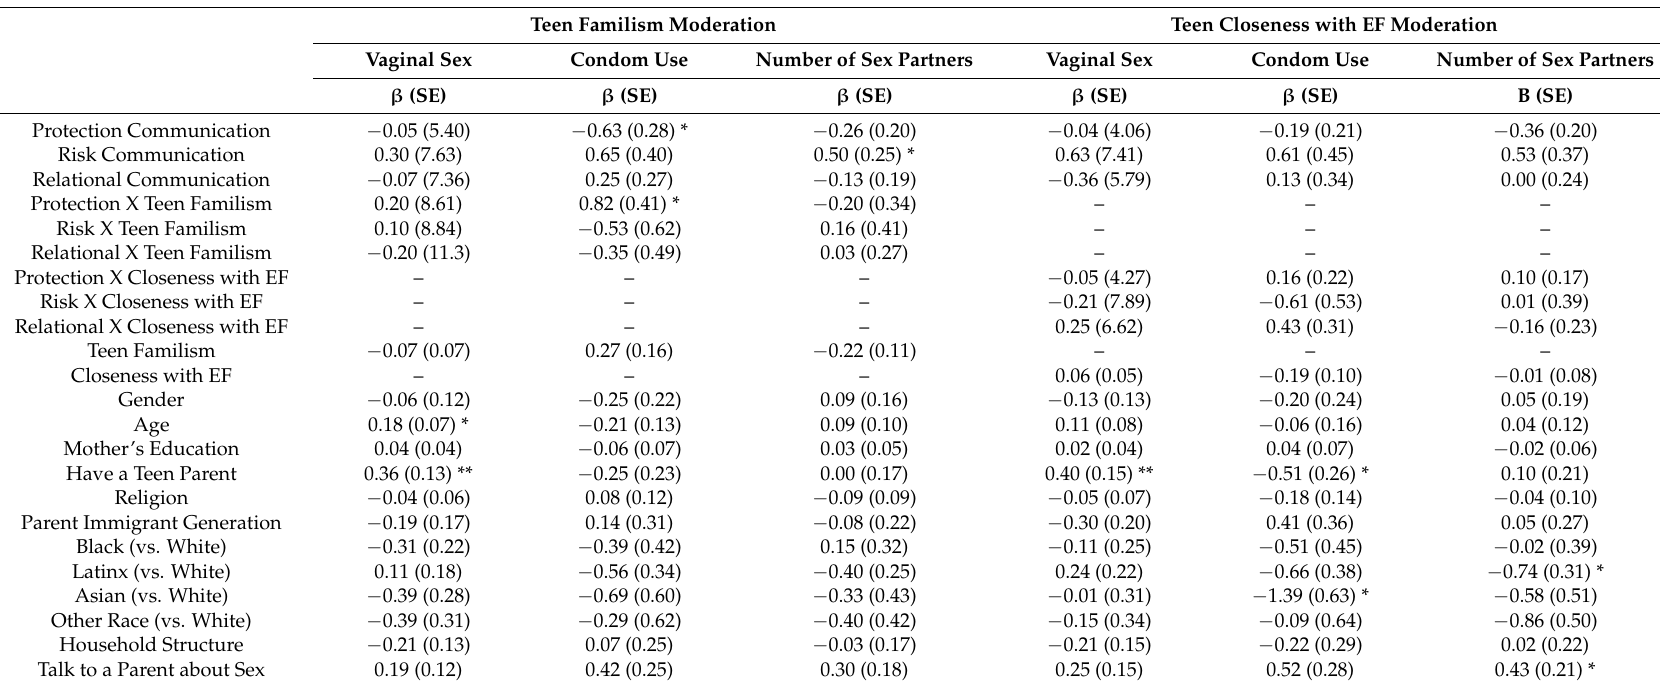
Table 3. Teen familism and teen extended family (EF) closeness as moderators of the relationship between EF communication and teen sexual